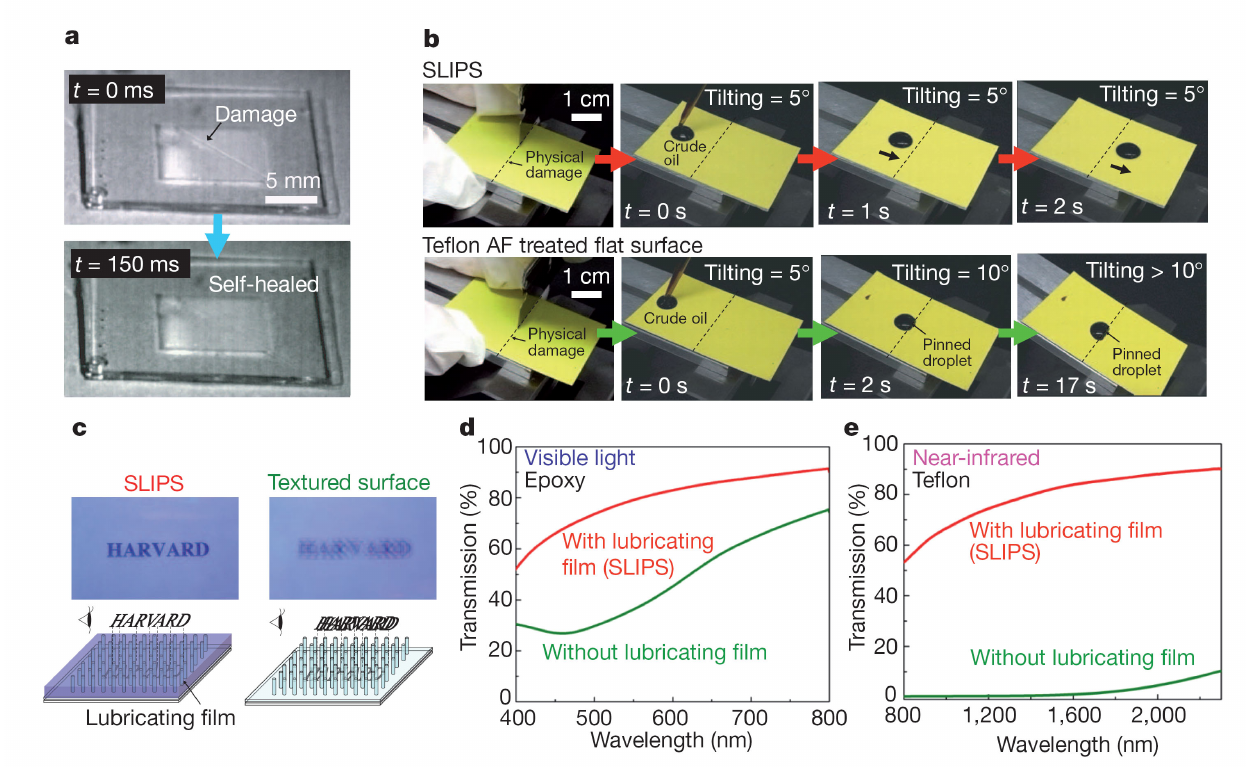
Figure 42. Self-healing and optical transparency of Slippery Liquid-Infused Porous Surfaces (SLIPS). ( a ) Time-lapse images showing capability of SLIPS to self-heal from physical damage ∼ 50 µ m wide on timescale of order of 100 ms; ( b ) Time-lapse images showing restoration of liquid repellency of SLIPS after physical damage, as compared to typical hydrophobic flat surface (coated with DuPont Teflon AF amorphous fluoropolymers) on which oil remains pinned at the damage site. ( c ) Optical images showing enhanced optical transparency of epoxy-resin-based SLIPS (left) as compared to significant scattering in non-infused superhydrophobic nanostructured surface (right) in visible light range. Top panels show top views; bottom panels show schematic side views. ( d ) Optical transmission measurements for epoxy-resin-based SLIPS in the visible light range (400–750 nm). ( e ) Optical transmission measurements for Teflon-based SLIPS in the near-infrared range (800–2300 nm). From Wong et al.